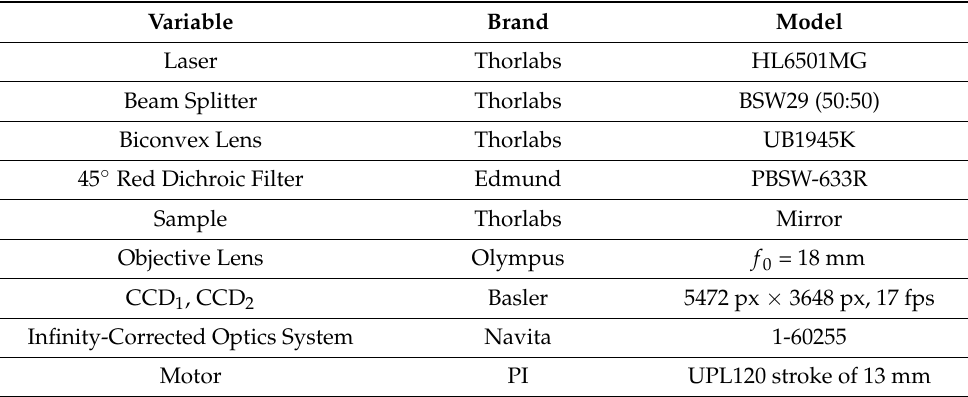
Table 1. Design parameters of proposed autofocusing microscope.